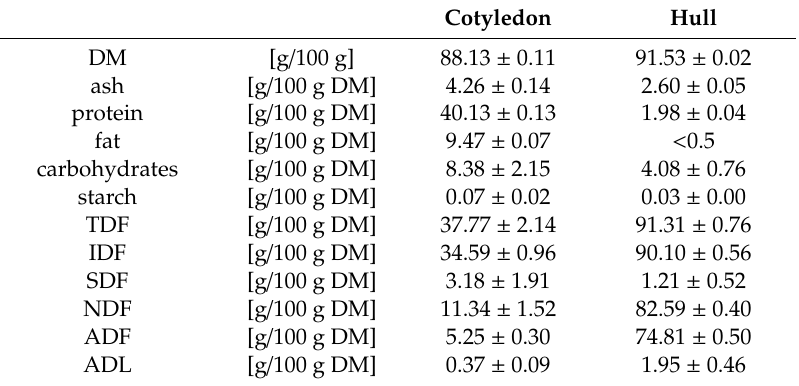
Table 1. Chemical (dry matter (DM), ash, protein, fat, carbohydrates) and dietary fibre composition (total dietary fibre (TDF), soluble dietary fibre (SDF), insoluble dietary fibre (IDF), neutral detergent fibre (NDF), acid detergent fibre (ADF), and acid detergent lignin (ADL)) of the cotyledon and the hull of L. angustifolius L. Boregine ( n =